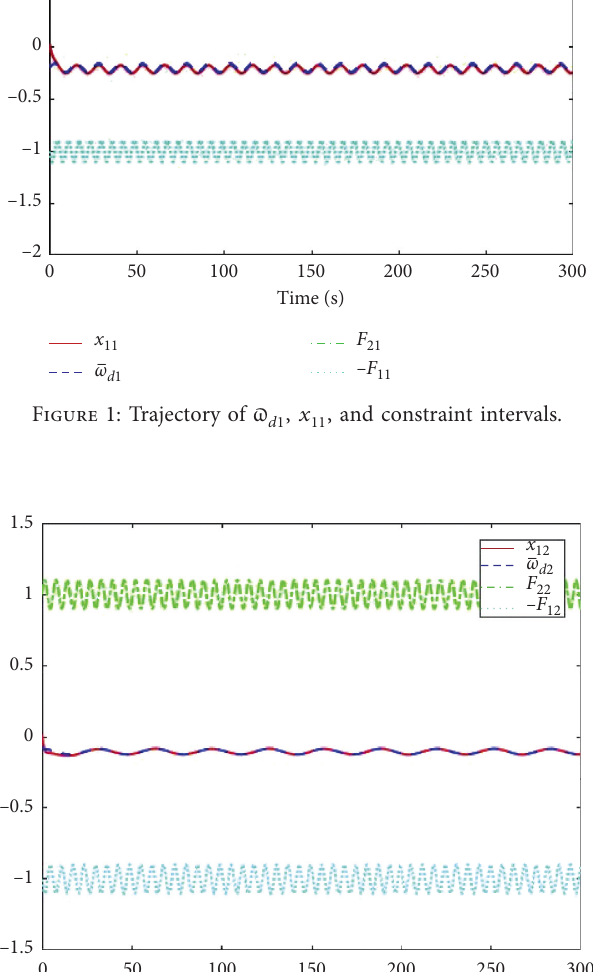
x , and constraint d 2 , 12